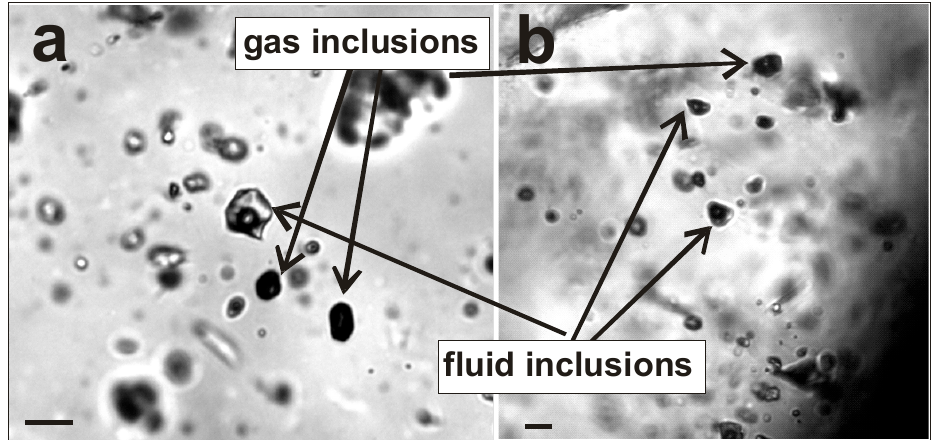
Figure 9. Rare primary aqueous-dominated and gas-dominated fluid inclusions of heterogeneous capture in quartz from high-grade quartz-molybdenite veinlets ( a ) and molybdenite-poor veinlets ( b ) of the Pervomaiskoe deposit. The length of the scalebar—10 microns.